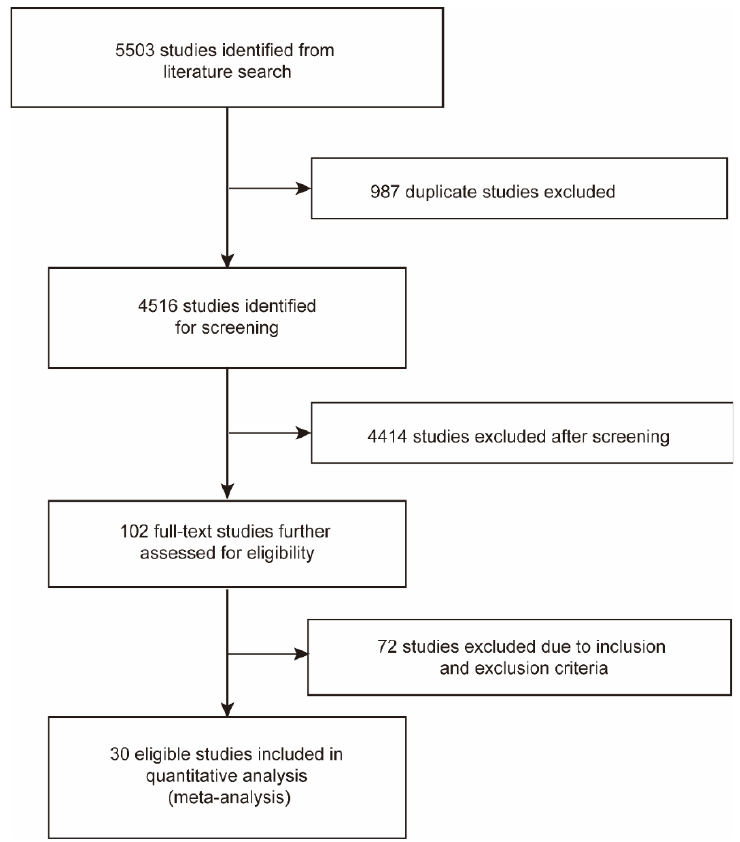
Figure 1. Flow chart of the literature search and study selection process.